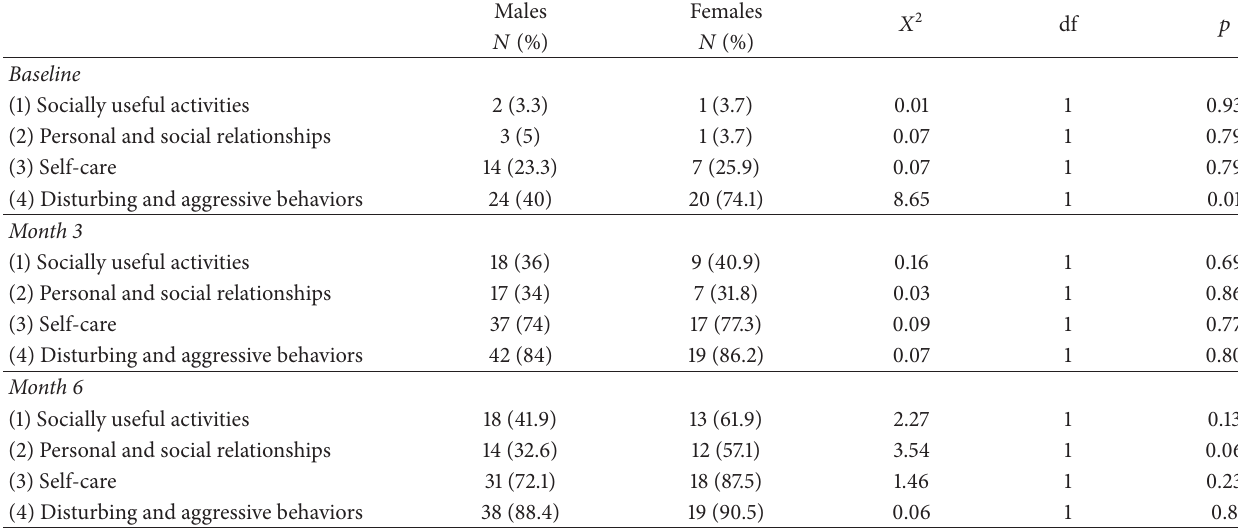
Table 4: Percentage of subjects showing a good functioning in the PSP subscales during the followup.